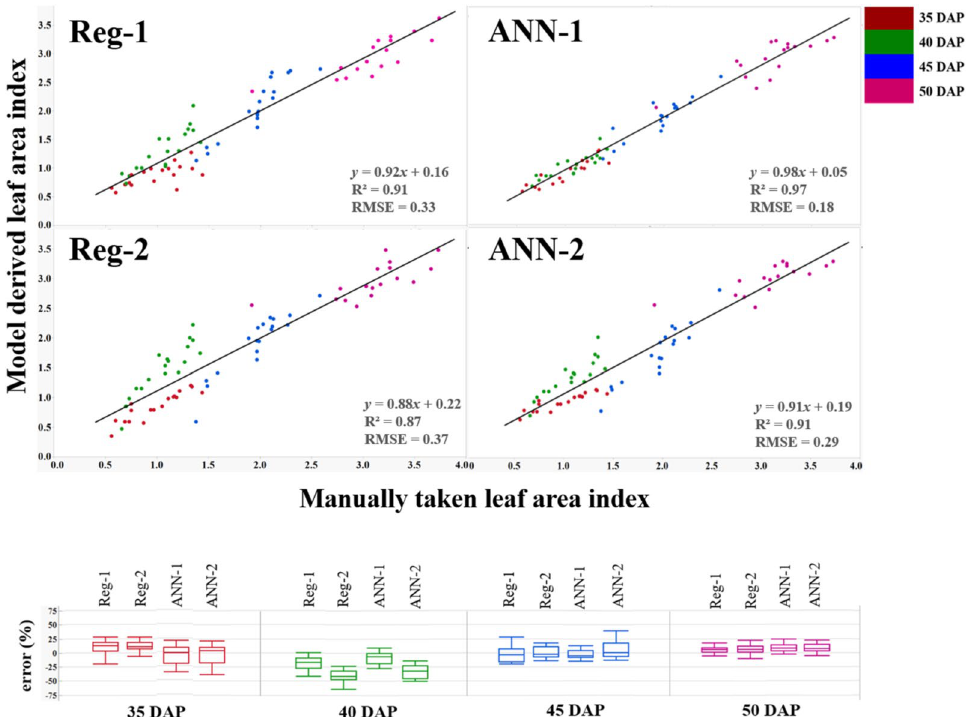
Figure 6. Comparison of manually taken leaf area index (LAI) using a ceptometer and derived LAI ( y -axis) in 2017 ( x -axis) using: Reg-1: LAI = 28.82 × BGI + 13.77 × PPR-7.91 × NGRD + 14.88 × NCPI + 25.86 × NPPR-39.74; Reg-2: LAI = 505.84 × (BGI × PPR × NPPR × NGRDI × NCPI) + 0.134; ANN-1: BGI, PPR, NPPR, NGRDI, and NCPI as predictors of LAI ; ANN-2: product of BGI, PPR, NPPR, NGRDI, and NCPI as predictors of LAI. Each point on the graph represents LAI of every genotype at different days after planting (DAP) averaged over six replications. The box and whisker plots represent the error statistic of estimation models at different DAP. In each box, the central mark is median, and the lower and upper edges denote the 25th and 75th percentile of errors respectively. The whiskers extend to the most extreme data points not considered outliers. Outliers not shown on the chart for